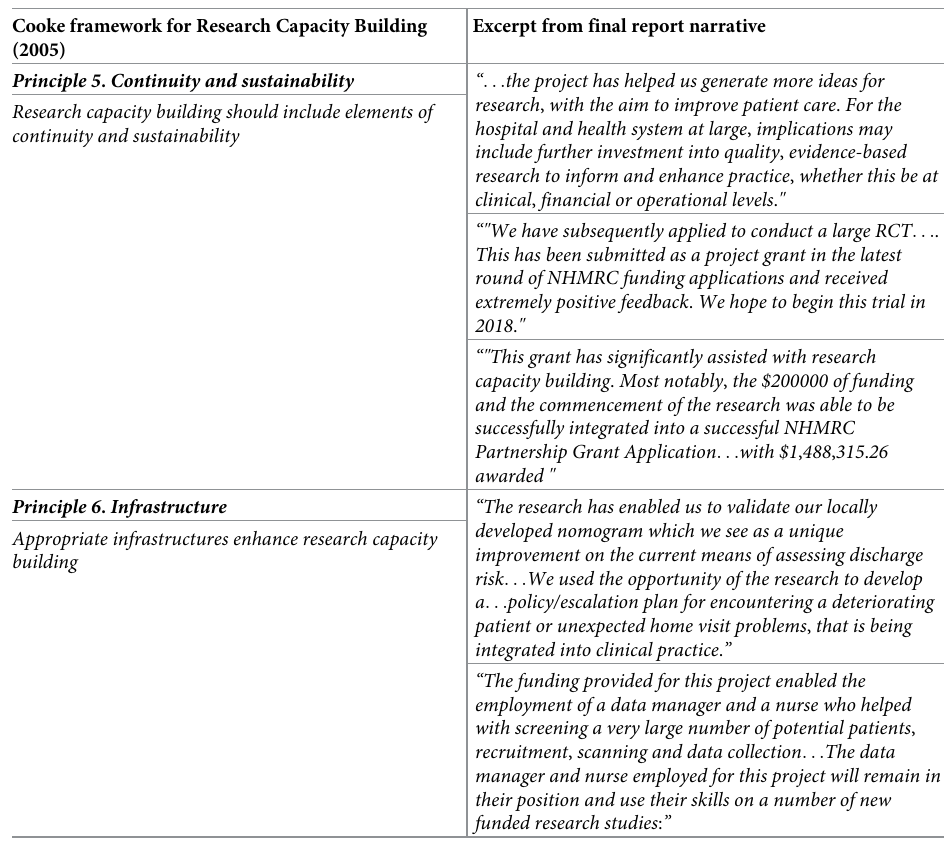
(Fig 2). To illustrate the collaboration between academics and service providers, academic organisations are represented as purple nodes and clinical service organisations as orange nodes. For details of organisations included in each group, refer to Table 2. It is important to note that two nodes, identified in green represent consumers or consumer representative